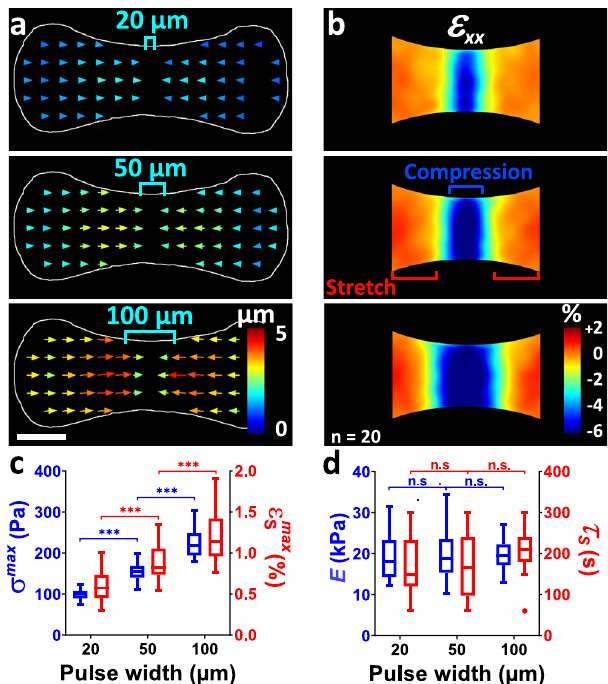
Fig. 4 | Light-driven probing of the apparent elastic modulus of microtissues. Average displacement ( a ) and ε xx strain ( b ) fi elds resulting from 20 µ m, 50 µ m and 100 µ m wide light stimulations (symbolized by blue brackets). For readability rea- sons, only half of the displacement vectors are represented. Scale bar is 100 µ m. c Correspondingmaximumstress σ max andstretch ε max S . d Resultingelasticmodulus E,reportedas σ max / ε max S ,andtimedelay τ S between σ max and ε max S infunctionofthe pulse width. Data are presented as Tukey box plots (i.e. the box extends from the 25th to 75th percentiles, the median is plotted as a line inside the box and the whiskers extend to the most extreme data point that is no more than 1.5 times the interquartile range from the edge of the box) with n =20 microtissues over 2 independent experiments. *** P <0.001 between conditions. n.s. stands for non- signi fi cant (i.e. P >0.05). Statistical signi fi cances were determined by